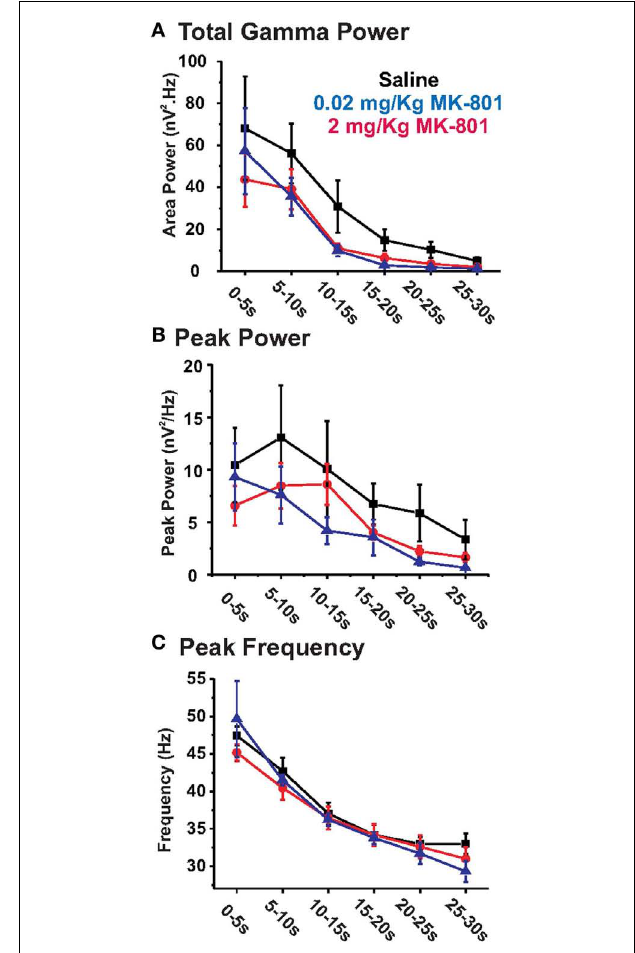
FIGURE 2 | Chronic ketamine treatment leads to decreases in the power and peak frequency of KA-elicited PrL oscillations . Graphs show the effects of chronic ketamine given at daily doses of 5mg/kg (blue) or 30mg/kg (red) on (A) total GBO power (40–50Hz), (B) peak power, and (C) peak frequency across 30s of the elicited oscillatory response recorded from acute PrL slices. Compared to saline treated controls (black), mice receiving 30mg/kg ketamine showed a significant decrease in both total GBO power (between 5 and 20s; see Table 1 ) and the peak frequency of elicited activity. No change was observed in peak power. At 5mg/kg, chronic ketamine had no significant effect on total GBO power or peak power. While a decrease in peak frequency was still apparent at this concentration, this effect was only significant in the 20–25 and 25–30s epochs.